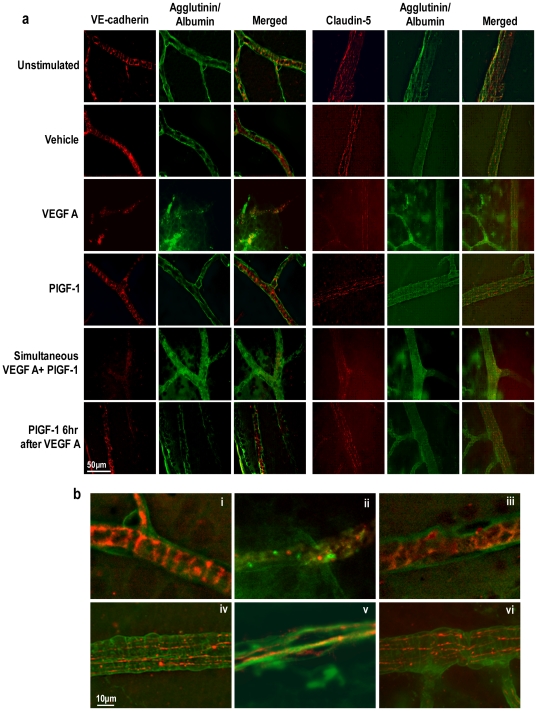
PlGF-1 stabilizes both AJs and TJs in retinal vessels of mice following VEGF-induced vascular permeability.The upper panel (a) shows representative confocal images of retinal vessels in flat mount preparations from control (no injection) C57BL/6 mice and animals receive a 1 µl intravitreal injection of: vehicle (PBS); VEGFA; hPlGF-1; simultaneous VEGFA + hPlGF-1; VEGFA followed by hPlGF-1 6 hours later. VEGF was given at a concentration of 60 ng/µl and hPlGF-1 at 60 ng/µl. 46 hours post the first injection mice received tail vein injections of FITC-labeled albumin. Two hours later, animals were perfusion fixed with paraformaldehyde. Retinas were prepared as flat mounts and immunostained with VE-cadherin or claudin-5 (red) and FITC-conjugated agglutinin to visualize retinal vessels. (n = 10-20 per group). Scale bar  = 50 µM. The lower panel (b)shows representative merged higher power images of retinal vessels stained for VE-cadherin or claudin-5 (red) and FITC-conjugated agglutinin (green). Scale bar  = 10 µM.